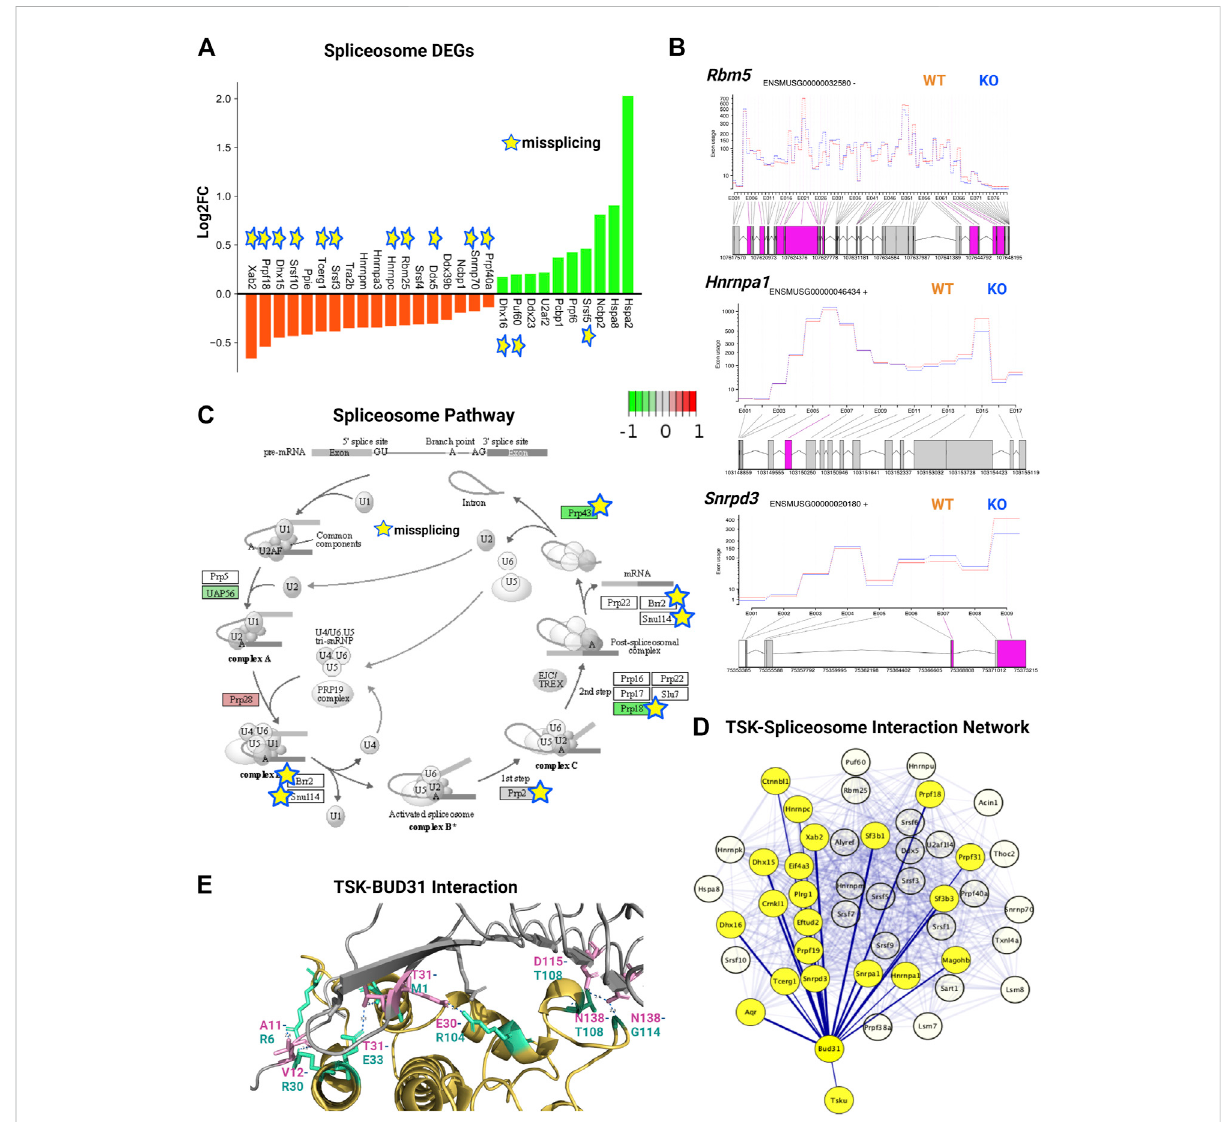
FIGURE 7 TSK de fi ciency alters spliceosome integrity. (A) Expression of spliceosome-associated DEGs. Green indicates increased expression, whereas orange indicates decreased expression. Star indicates misspliced proteins inferred from the DEU genes. The boxes without any color or star indicate that the pathway component does not correspond to DEG or DEU genes. (B) Fitted splicing plot of DEU in representative spliceosome-associated genes.Pinkindicatestheexonwithsigni fi cantdifferentialexonusage. (C) SpliceosomepathwaymapforassociatedDEGsandDEUgenes.Each rectangular box indicates a protein component of the pathway. Arrow indicates the activation targets of the pathway components. The green to red gradient indicates the level of expression. Star indicates the proteins inferred from the misspliced encoding genes. (D) String-based analysis of protein-protein interactions of TSK with DEU spliceosome genes. The nodes represent proteins. Yellow colored nodes represent the fi rst neighbors of TSK-interacting proteins Bud31. The thickness of the edges is proportional to their con fi dence scores (Minimum con fi dence score for the interaction = 0.4). (E) Interaction surface between TSK and spliceosome factor BUD31. The contacting amino acids are shown in magenta (TSK) and cyan (Bud31) sticks. Interacting amino acid (with position) pair (TSK-BUD31) are shown in respective colors. Dotted lines between interacting atoms represent polar contacts. The number value in the polar contact lines indicates the distance between the interacting pair in Angstrom